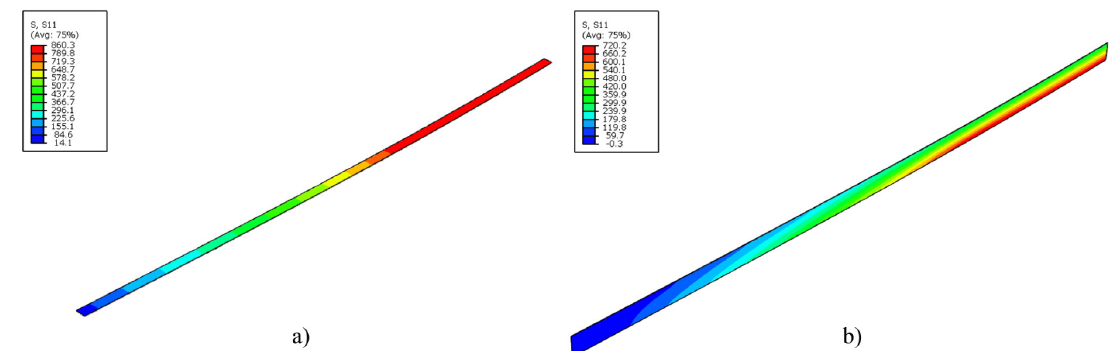
Fig. 12. Normal σ 11 stress (MPa) distributions in CFRP plate at ultimate load: a) for Series B beams and b) for Series E